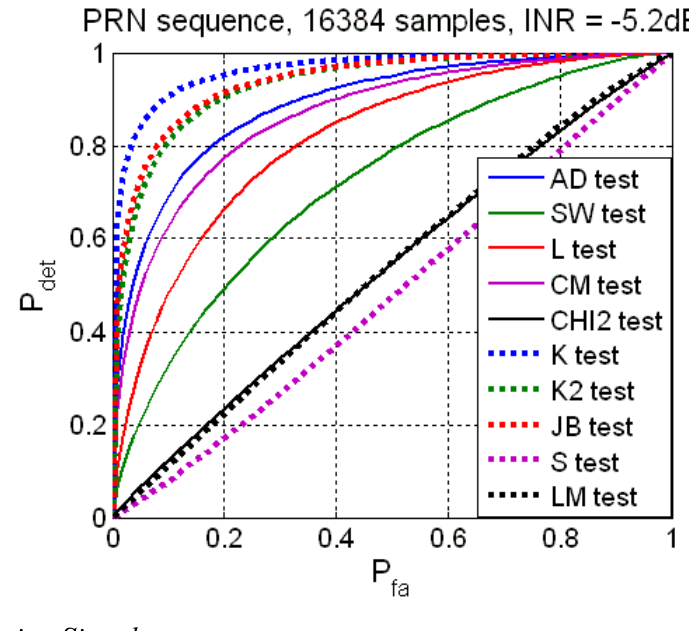
Figure 9. Normality tests performance in the detection of a PRN interference signal. Sample size is 16,384 and INR is − 5.2 dB. It is appreciated the difference in performance between the Kurtosis and the rest of tests. Also, bad performance of the Skewness, LM